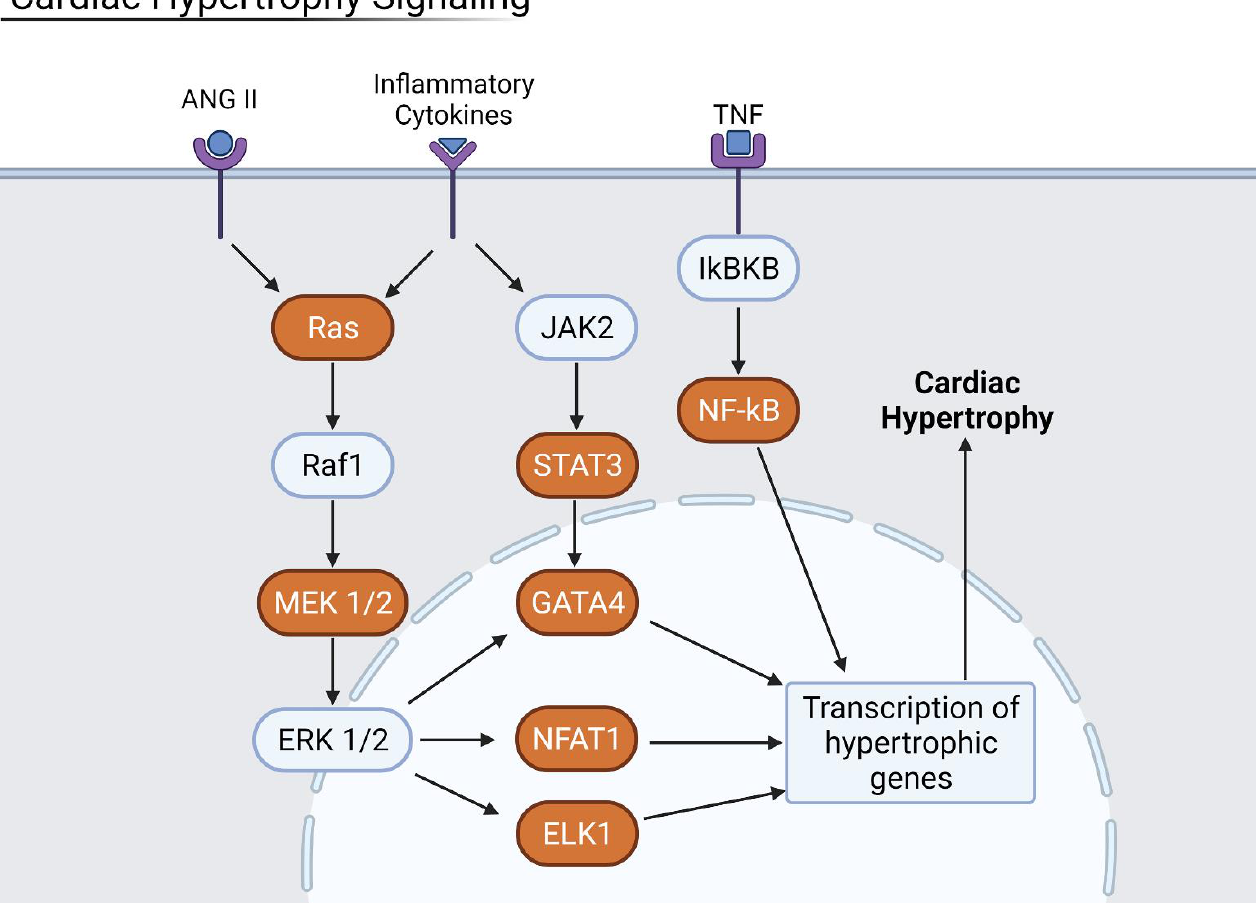
Figure 10. Cardiac Hypertrophy pathway where orange proteins are upregulated. ANGII, inflammatory cytokines, and TNF — all increased during COVID-19 infection — upregulated the cardiac hypertrophy signaling pathway. Generated in Biorender.